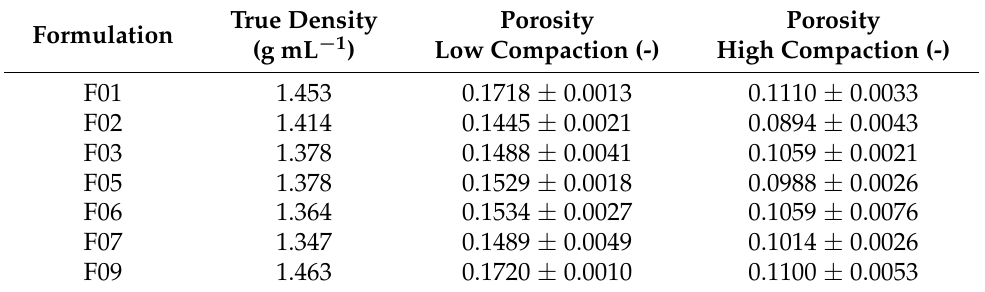
Table 2. Summary of the true density and calculated porosity (Equation (1)) for all batches.